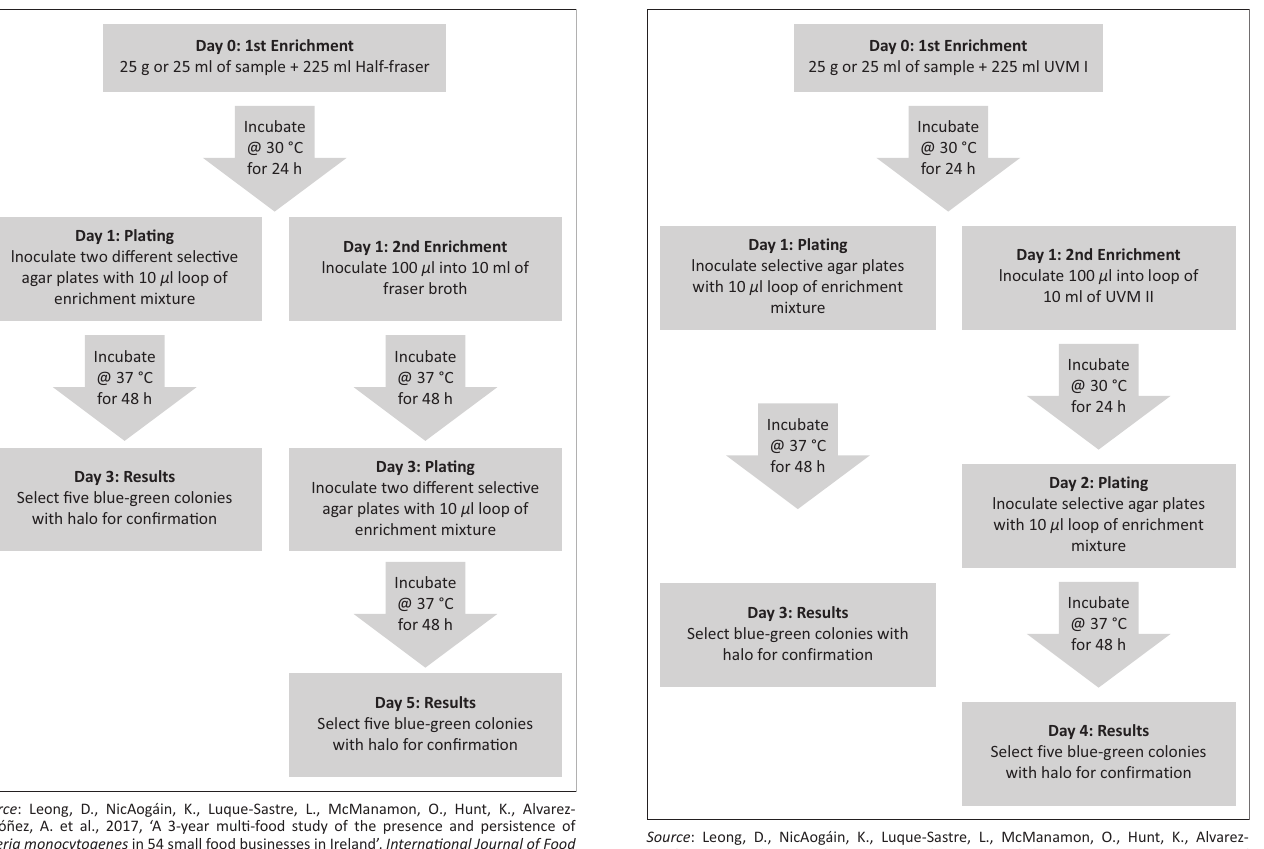
FIGURE 4: The illustration of International Standard method.